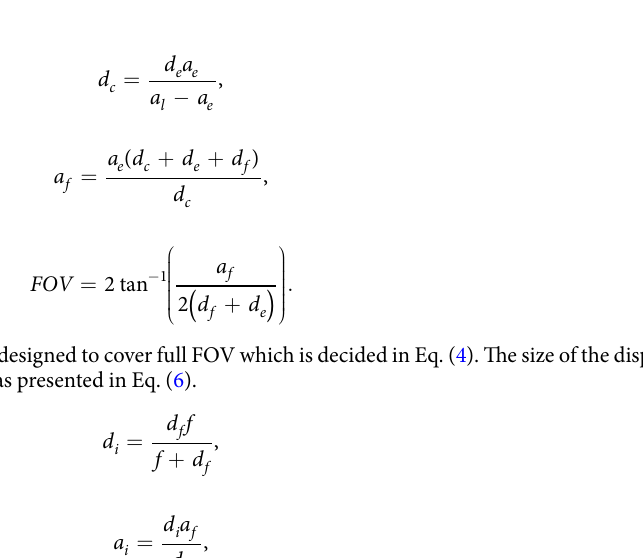
Figure 4. Schematic diagram of AR-HMD system using IMACL: ( a ) left eye shows transparent mode of the IMACL and right eye shows the lens mode of the IMACL, and ( b ) the principle of the FOV of AR-HMD system using